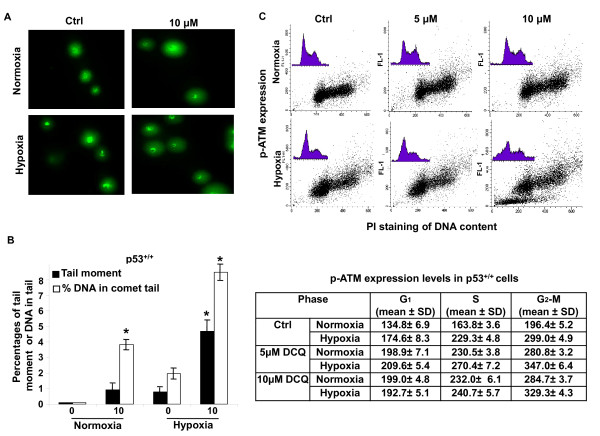
DCQ induces DNA damage and increases ATM expression in p53+/+ HCT116 cells. SSB and DSB induced by DCQ in p53+/+ cell line. (A) Examples of comets induced by DCQ in cells subjected to the alkaline comet assay. Cells treated with DCQ for 6 hrs in normoxia or hypoxia were collected directly after treatment, subjected to the alkaline comet assay and images were taken using a fluorescent microscope at 40× (oil immersion) magnification. The comets observed by each treatment are directly proportional to the amount of SSBs induced. (B) The mean of the parameters (% DNA in comet' s tail and tail moment) are shown in the graphs above. More than 50 cells per treatment were photographed and quantified using TriTek CometScore software. (*) indicates p < 0.05 (one way ANOVA) with respect to control. (C) DCQ-induced phosphorylation of ATM in p53+/+ cells at 6 hrs as an indication of DSB. After treatment, cells were fixed and subjected to immunocytochemical detection of ATM phosphorylated on Ser-1981, and stained with PI to detect at the same time p-ATM in each phase of the cell cycle. The mean of the FL-1 intensity ± SD (reflecting the level of p-ATM expression) at the G1, S and G2M phases of the cell cycle are shown in the table. The experiment was repeated twice each in duplicates.